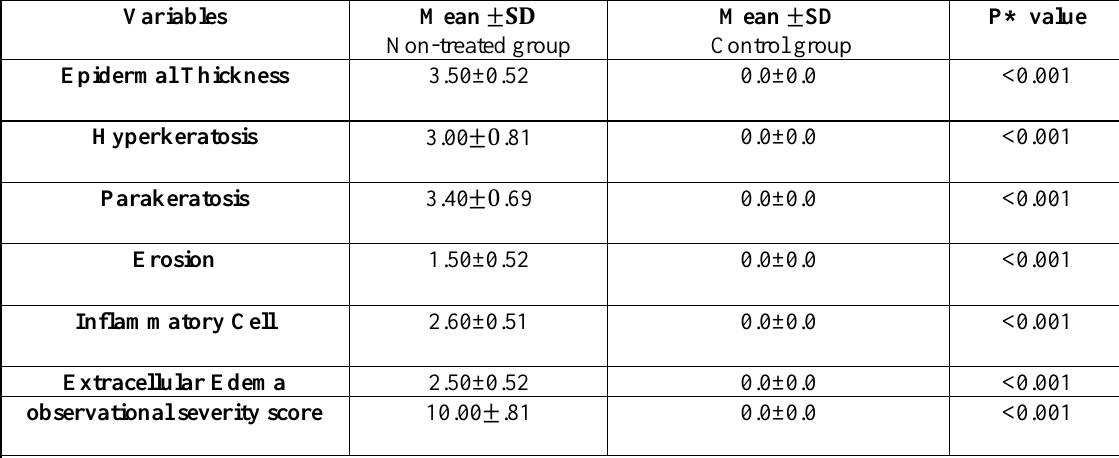
Table 2. Comparison between controls and non-treated atopic dermatitis induced group regarding histopathological scores, and observational severity score.